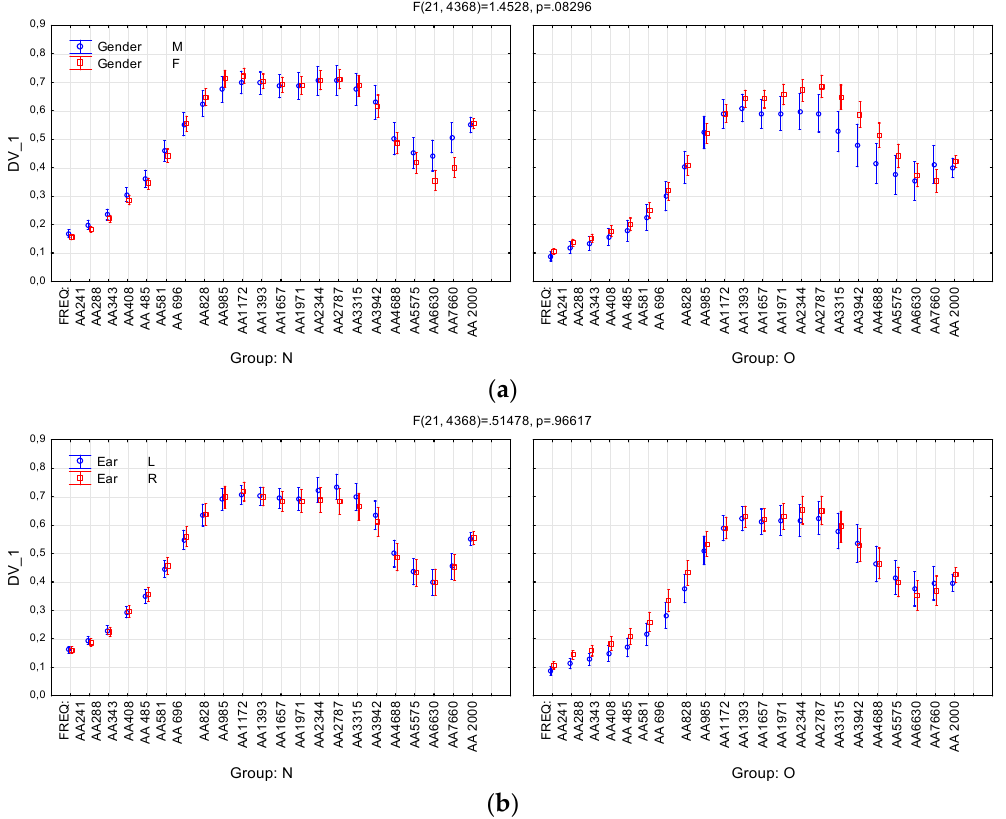
Figure 7. E ff ects of second-order interactions between the variables Group (N—Normal group; Figure 7. Effects of second-order interactions between the variables Group (N — Normal group; O —